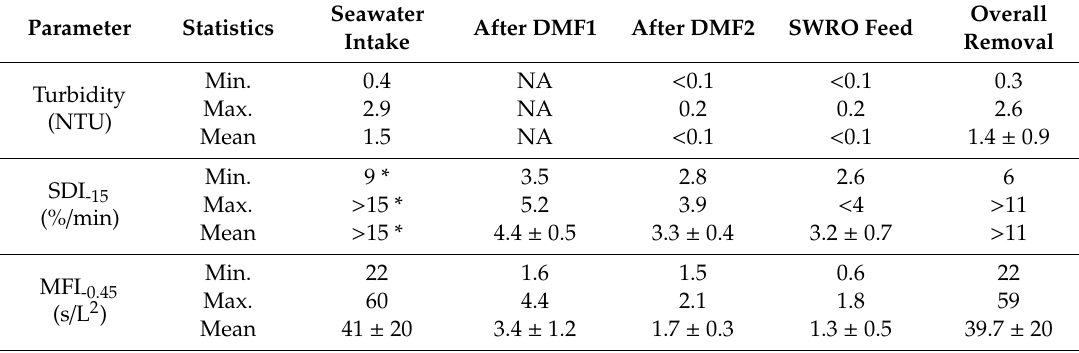
Table 3. Turbidity, silt density index (SDI) and modified fouling index (MFI) -0.45 along the pre-treatment of the SWRO plant over a period of 5 months (n =